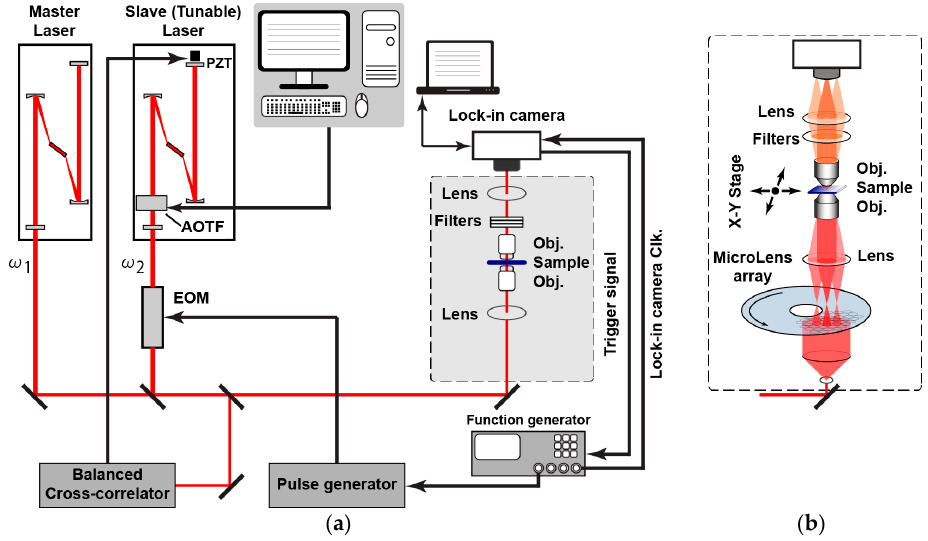
Figure 13. Experimental setup for SRS: ( a ) the setup used to characterize the pixel; ( b ) the lens setup to be used for image sensor array.